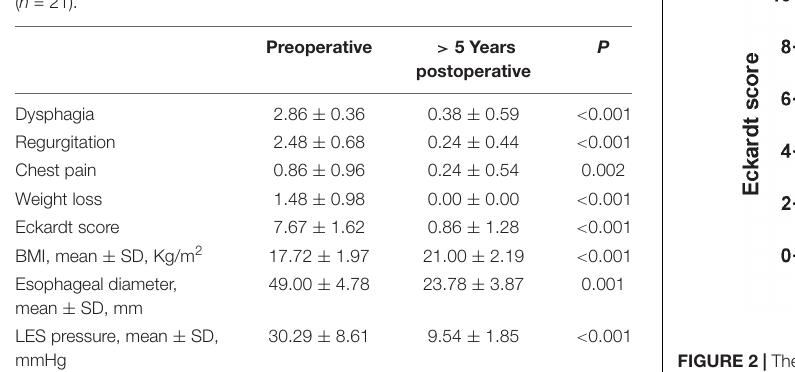
TABLE 2 | Comparison of clinical response outcomes pre and postoperatively ( n = 21).